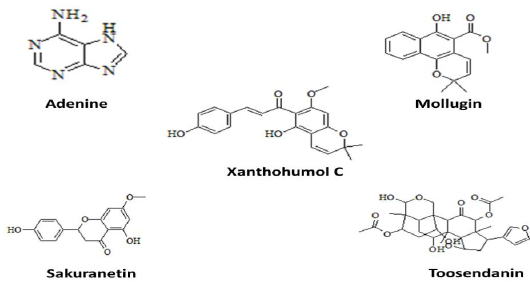
Figure 2. 2D structures of top five plant compounds. Adenine bound to FUR protein with a binding score of − 18.7 kcal/mol by creating hydrogen bonds with the side chains of Asn A72,Phe A73,Gly A75,Glu A74, whereas Mollugin is bound with a binding value of − 16.2 kcal/mol by making hydrogen bonds with Glu A74,Arg B70,Gly A76,Asn A72,Gly A75. Adenine and Mollugin bind strongly to FUR active residues, followed by Xanthohumol C, Sakuranetin, and Toosendanin, which have binding scores of − 14.5 kcal/mol, − 13.6 kcal/mol, and − 13.1 kcal/mol, respectively (Table 3). All ligands, excluding Sakuranetin, created strong hydrogen bonds with the conserved Gly A75 (Figure 3).